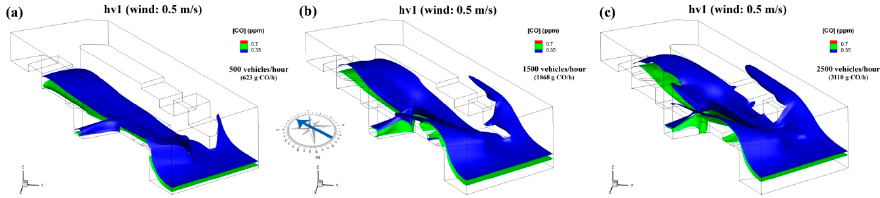
Figure 13. Iso-surfaces of CO concentration (blue 0.35 ppm and green 0.7 ppm) in the h1 case and a wind velocity of 0.5 m/s for a traffic intensity of ( a ) 500 vehicles, ( b ) 1500 vehicles, and ( c ) 2500 vehicles.